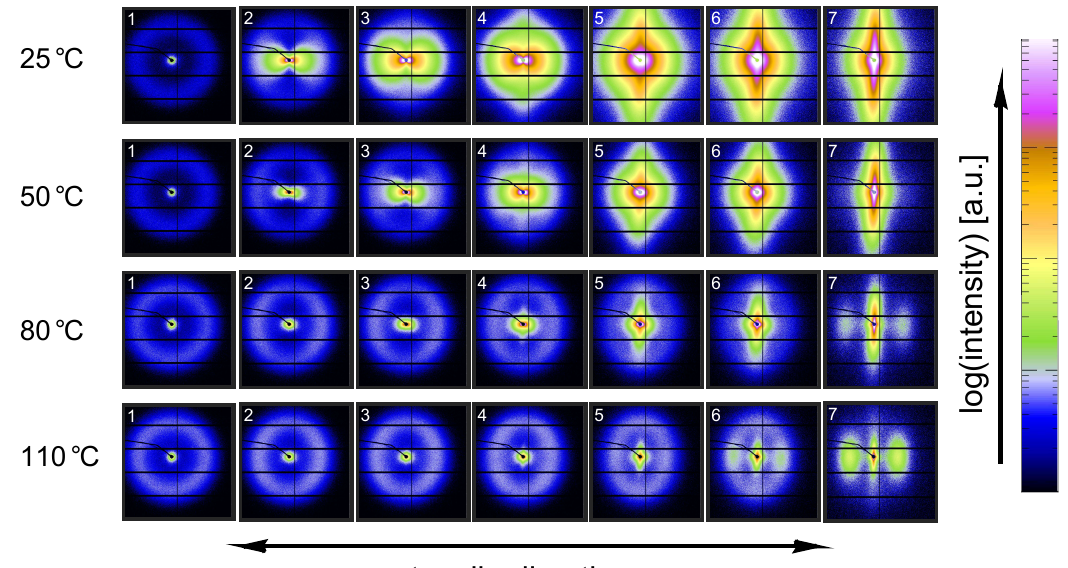
Figure 25. Normalized 2D SAXS patterns of γ -iPP stretched at temperatures of 25, 50, 80 and 110 ◦ C from top to bottom. The true strains, determined with the assumption of fully uni-axial deformation, are given as well. The macroscopic strains at which the patterns were taken are indicated by the markers in Figure 8. The stretching direction is